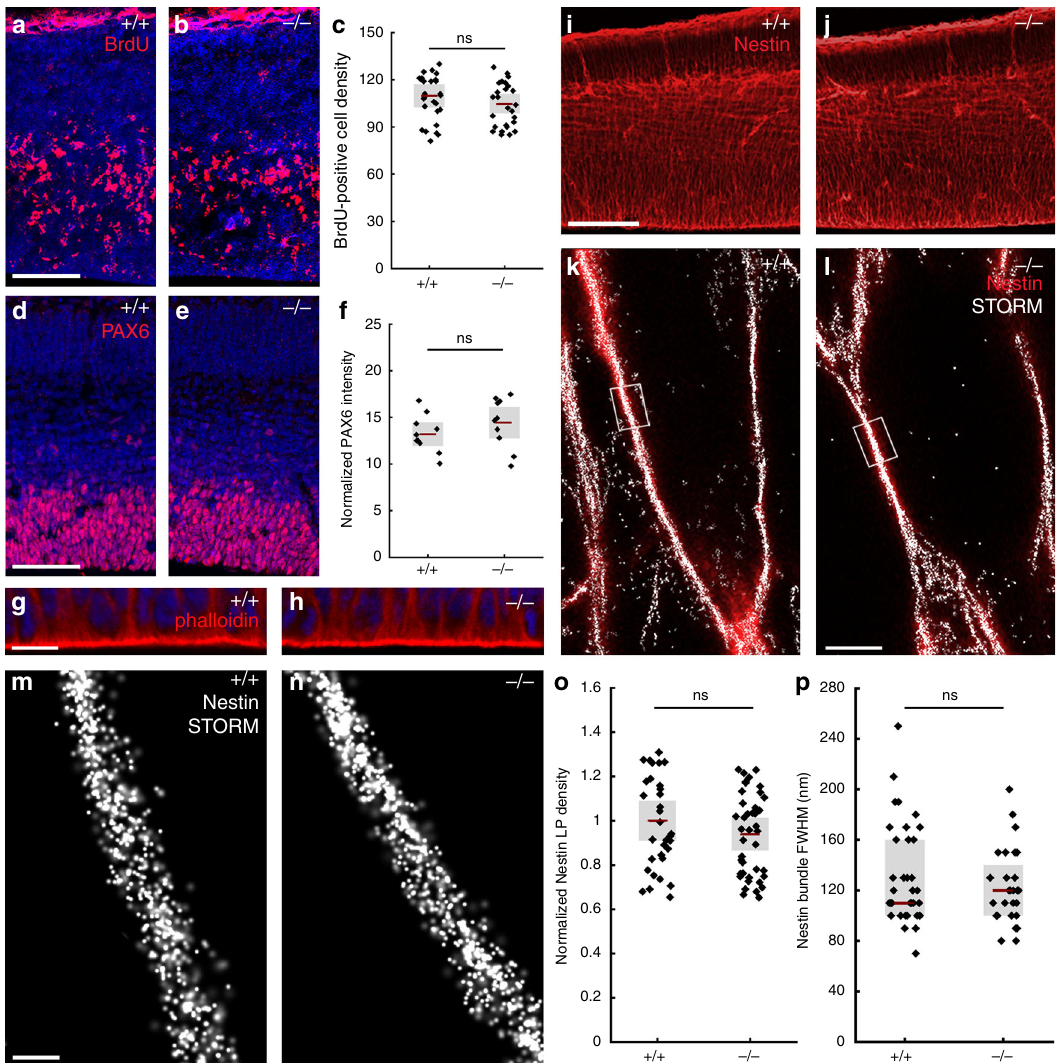
Fig. 4 ABHD4 is not required for classical radial glia progenitor cell functions. a , b Coronal sections of the embryonic cortex at E.14.5 show replicating cells that incorporated bromodeoxyuridine (BrdU) during S phase of the cell cycle are shown. c Quanti fi cation of BrdU-positive cell density (two-sided Student ’ s unpaired t test, P = 0.323; n = 38 sections from n = 6 animals per wild-type ( + / + ) mice, n = 29 sections from n = 4 animals per Abhd4- knockout ( − / − ) mice). d , e Confocal images and f quanti fi cation of PAX6-positive radial glia progenitor cells in the ventricular zone. (two-sided Student ’ s unpaired t test, P = 0.2598; n = 10 sections from n = 4 animals per wild-type ( + / + ) mice, n = 10 sections from n = 4 animals per Abhd4- knockout ( − / − ) mice). g , h Identical pattern of phalloidin-labeling of the adherens junction belt in the ventricular zone (VZ) of wild-type ( + / + ) and Abhd4- knockout ( − / − ) mice at E15.5. i , j Low-power confocal images show similar organization of nestin-positive radial processes in both genotypes at E15.5. k , l Correlated confocal and STORM super-resolution microscopy images from both genotypes. m , n STORM super-resolution images reveal that the nanoarchitecture of nestin intermediate fi lament bundles at the core of the radial glia processes remains intact in the absence of ABHD4. o Density of localization points (LPs) representing nestin (two-sided Student ’ s unpaired t test, P = 0.297; n = 39 segments from n = 3 animals per wild-type ( + / + ) mice, n = 57 segments from n = 3 animals per Abhd4- knockout ( − / − ) mice). p Quanti fi cation of full-width-at-half-maximum of nestin fi lament bundles (two-sided Mann – Whitney